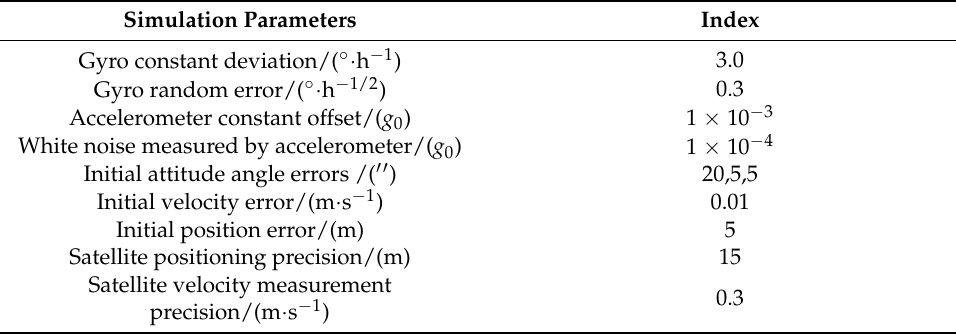
Table 1. Parameters of SINS/GPS integrated navigation simulation.